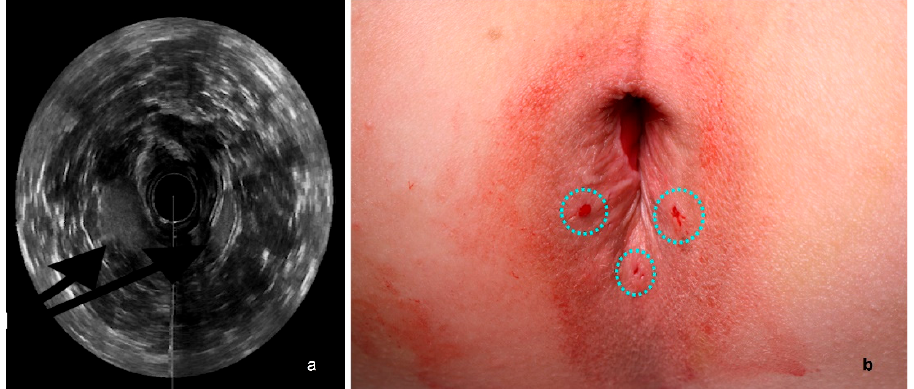
Figure 3. ( a ). Endosonographic axial sections of the middle anal canal after autologous fat grafting. The injected tissue is indicated by arrows. ( b ). Points of skin entrance of the cannula to reach the injection